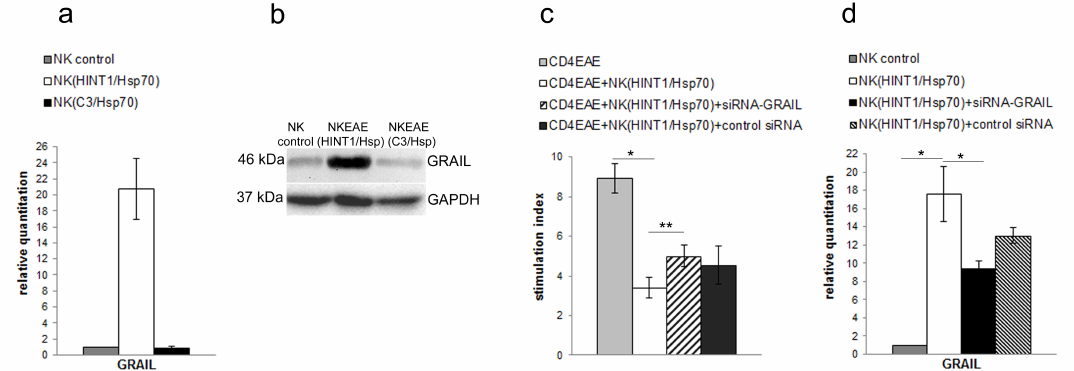
Figure 3. ( a ) Expression of mRNA for GRAIL was measured with qRT-PCR in NK cells isolated from naïve or HINT1 / Hsp70 or C3 / Hsp70 complex treated SJL / J mice. Ratio of mRNA was calculated versus the level of mRNA in NK cells isolated from naive mice. Data were pooled from four experiments with three to six mice per experiment; ( b ) GRAIL protein expression in NK cells isolated from naïve or HINT1 / Hsp70 or C3 / Hsp70 complex treated SJL / J mice was analyzed by Western blot with usage of anti-GRAIL antibody. GAPDH was used as loading control. Blot is representative of three independent experiments; ( c ) The PLP 139–151 induced proliferation of CD4 + T cells isolated from EAE SJL / J mice were cocultured with three di ff erent types of NK cells isolated from SJL / J mice treated with HINT1 / Hsp70 complex 1. non-transfected; 2 transfected with siRNA-GRAIL; and 3. transfected with control siRNA. After 72 h the proliferation was measured by [3H] thymidine uptake. Stimulation indices are shown as mean ± SD obtained from three independent experiments with three to six mice per experiment. * p < 0.001, ** p < 0.05; ( d ) Inhibition of mRNA GRAIL expression in NK cells isolated from SJL / J mice treated with HINT1 / Hsp70 by siRNA-GRAIL transfection. E ffi cacy of GRAIL mRNA inhibition with siRNA-GRAIL transfection was assessed by qRT-PCR. The ratio of mRNA was calculated versus the level of mRNA in NK cells isolated from naïve SJL / J mice. Data are pooled from three independent experiments with five to six mice per experiment. * p <